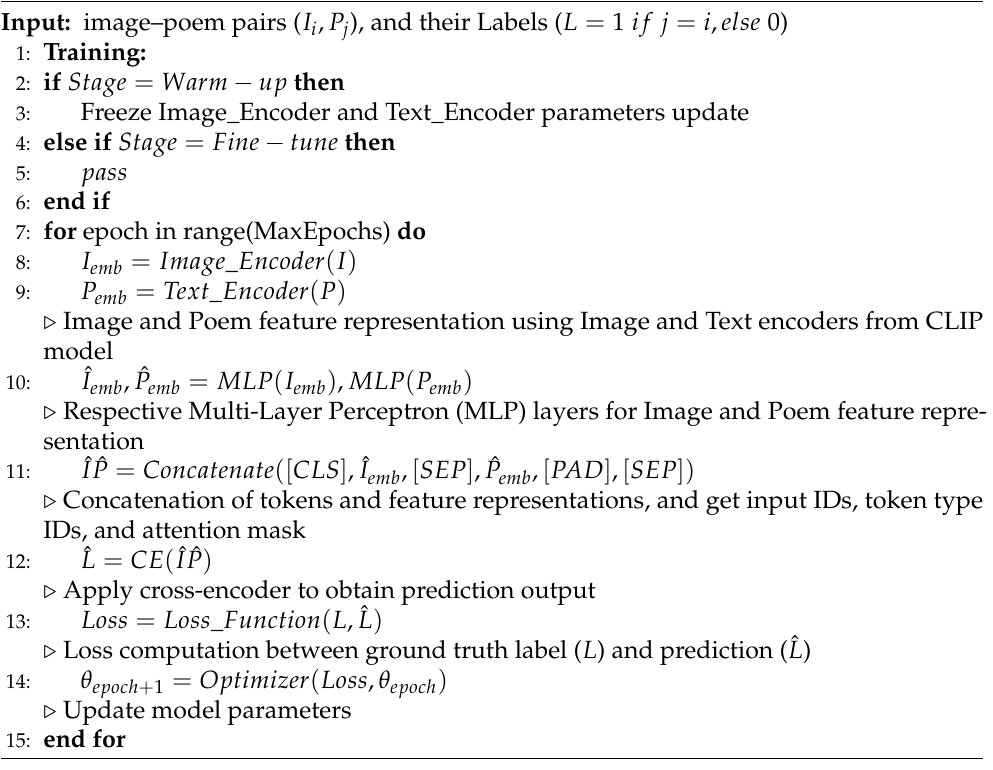
Algorithm 1 Training Process of Proposed